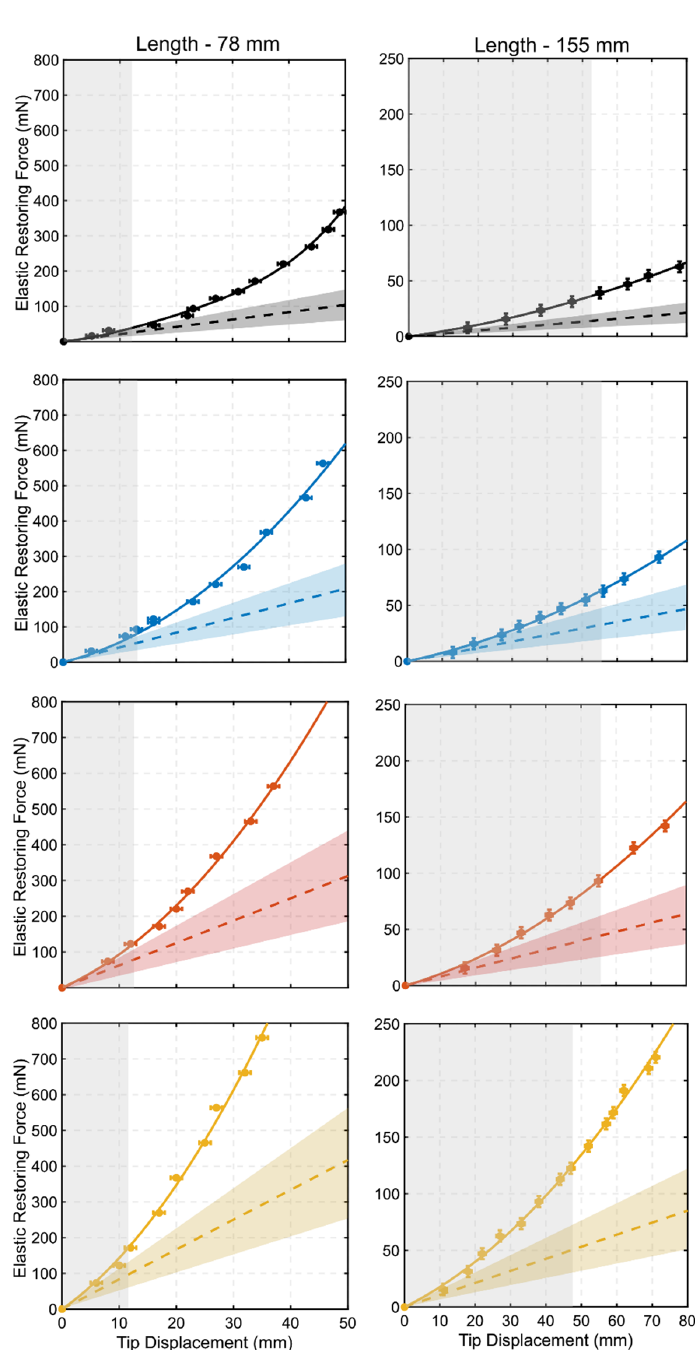
Figure A1. Measured elastic restoring force versus tip displacement. Markers represent the measured quantities from the experimental tests, with associated error ranges. The continuous lines are fitting lines to help visualize the trend in the experimental data. The dashed lines are the predictions from linear beam theory for the metal shim alone. The colorful shaded regions around the dashed lines are to indicate the potential ±40% error due to tolerance on the thickness of the metal shim substrate. The vertical shaded regions in grey correspond to the range of tip displacement values reported in this work.